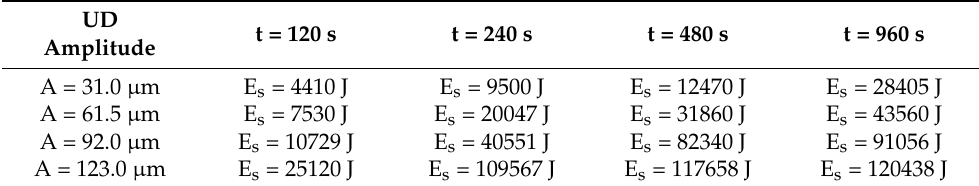
Table 2. Change in energy (E s ) introduced into the sample depending on the applied amplitude and sonication time.